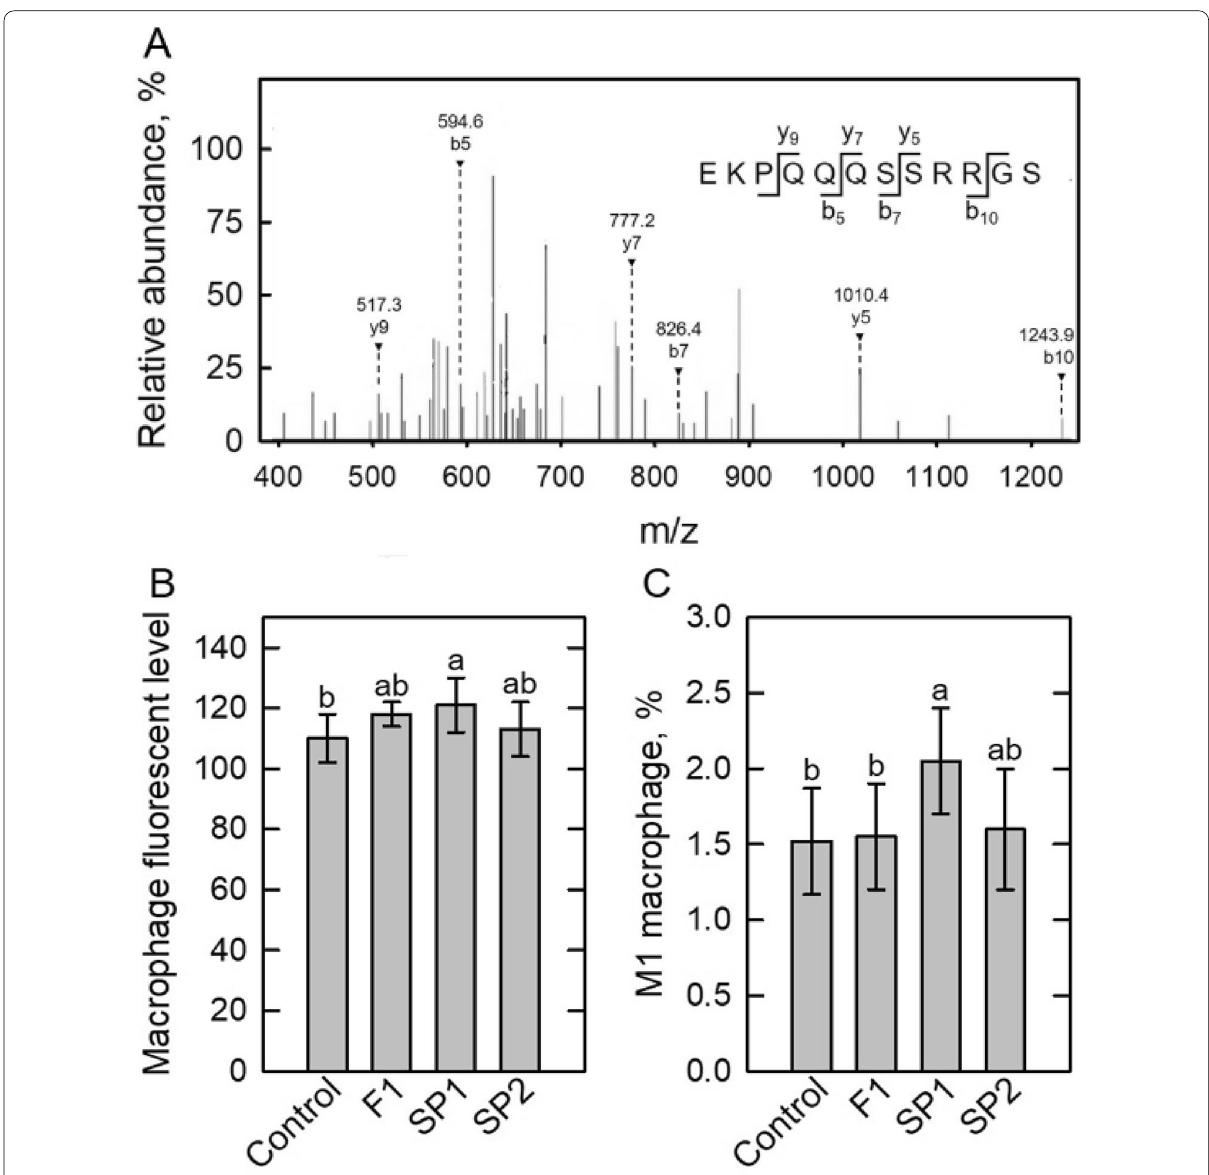
Fig. 6 Peptide identified from Pepsin‑ISPH4h‑1P F1 fraction. A the mass spectrum of a peptide, EKPQQQSSRRGS, identified by LC–MS–MS. Effects of the synthetic peptides, EKPQQQSSRRGS (SP1) and VVQGKGAIGFAFP (SP2), on positive fluorescent level in macrophages ( B ), and M1 ( C ) phenotype polarization in mouse spleen in vivo. Bars represent mean standard deviation (SD; n 3). Mean with different letters are significantly different ± = ( p < 0.05) by Duncan’s multiple range